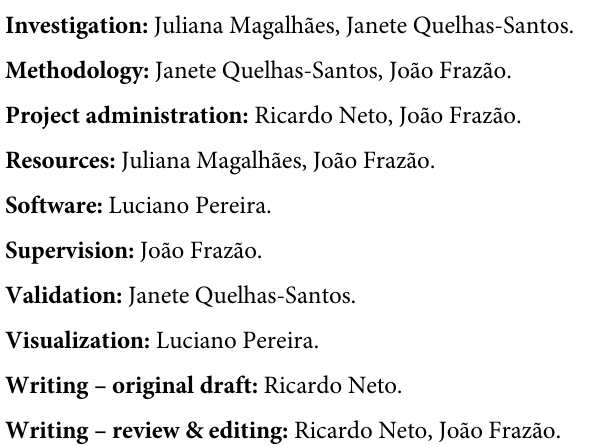
S1 Table. Demographic, clinical and laboratory characteristics of the study population according to diabetes